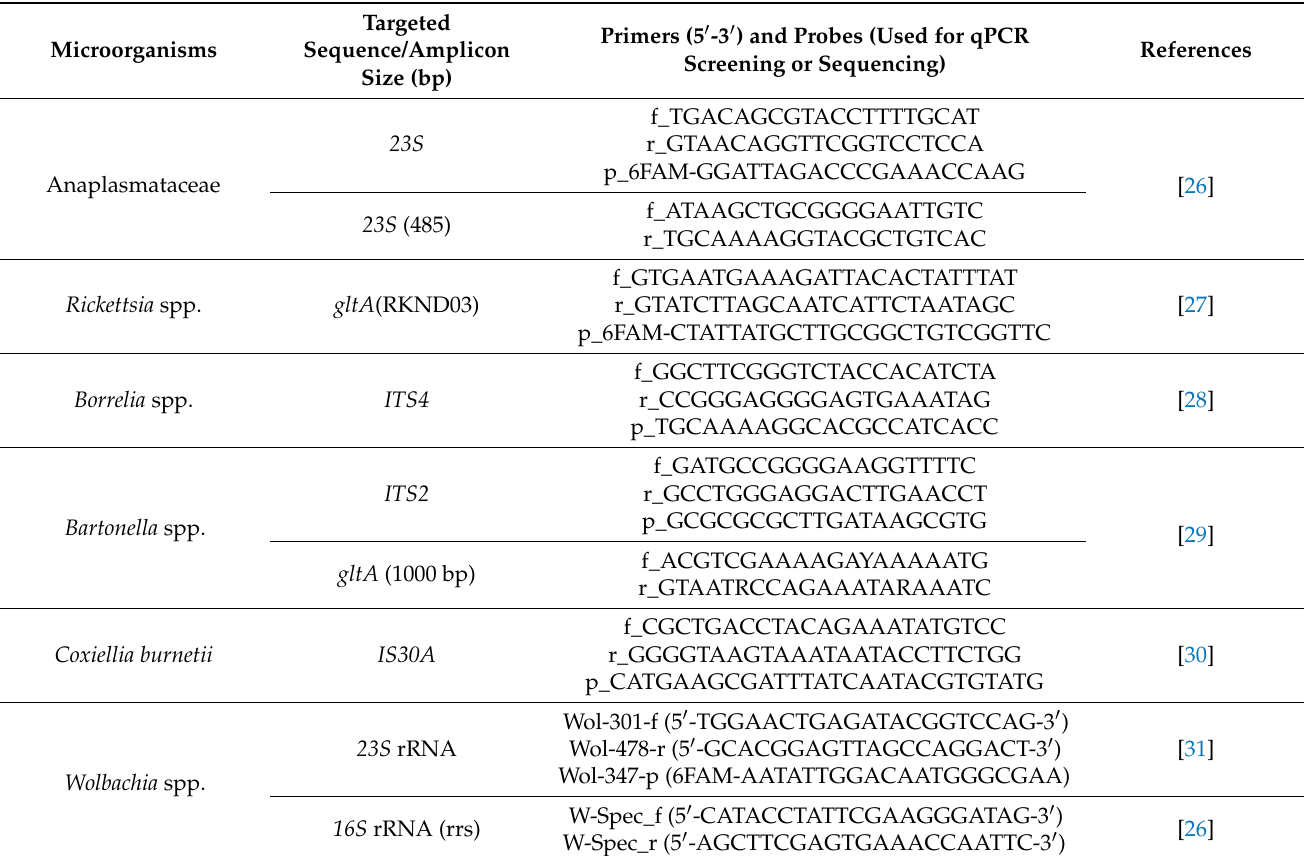
Table 1. Sequences of the primer sets used for fleas and flea-borne pathogen detection using qPCR and standard